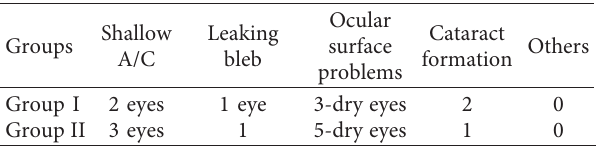
Figure 5: A diffuse slit-lamp image of a patient from Group II at one year of follow-up. Table 5: